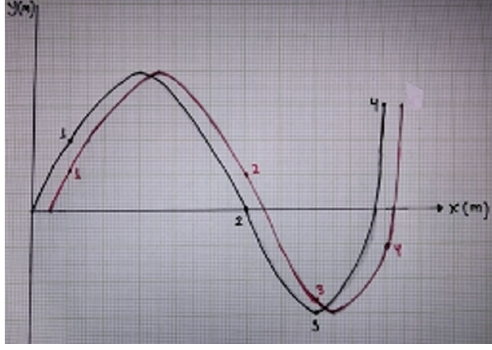
FIG. 11. Student ’ s drawing after scaffolding level 2.